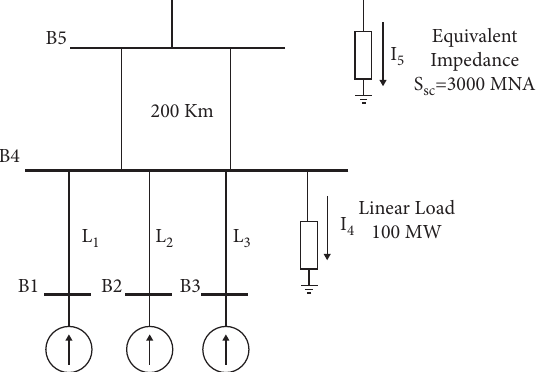
Figure 1: Transmission system summation